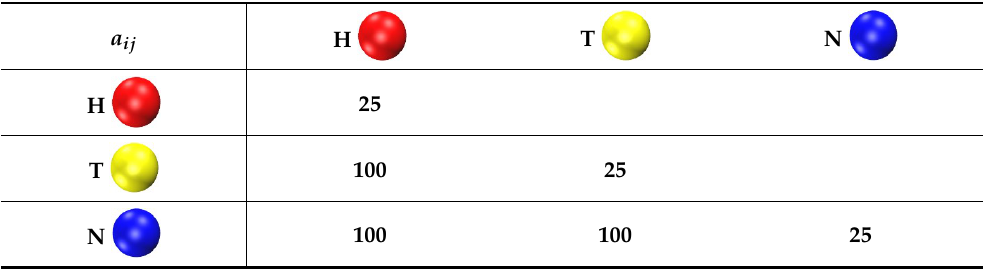
Table 1. The interaction parameter introduced in this article. H and T represent head and tail beads of lipid chain, N denotes nanoparticle